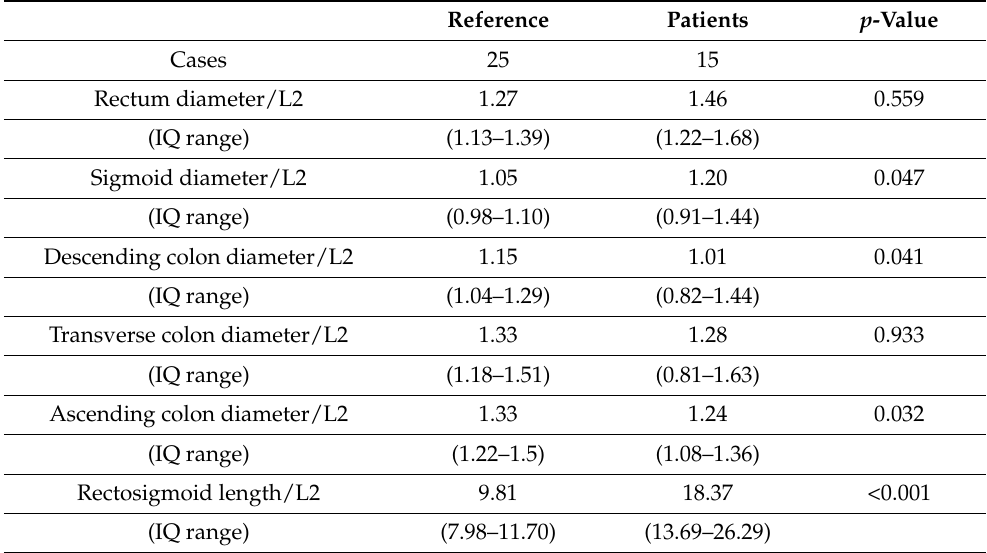
Table 1. Comparison of calculated ratios with those reported by the literature as normal (age 1